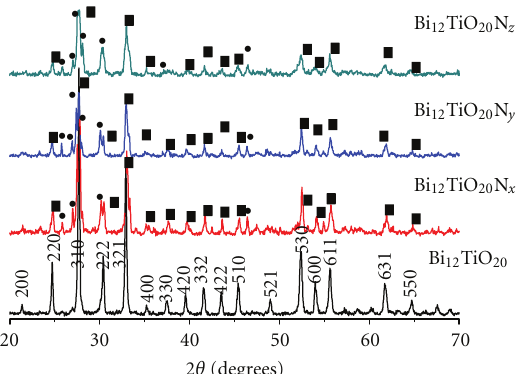
Figure 1: XRD spectrum of bismuth titanate: Bi 12 TiO 20 , Bi 12 TiO 20 − x N x ( x = 0 . 01), Bi 12 TiO 20 − y N y ( y = 0 . 03), and Bi 12 TiO 20 − z N z ( z = 0 .